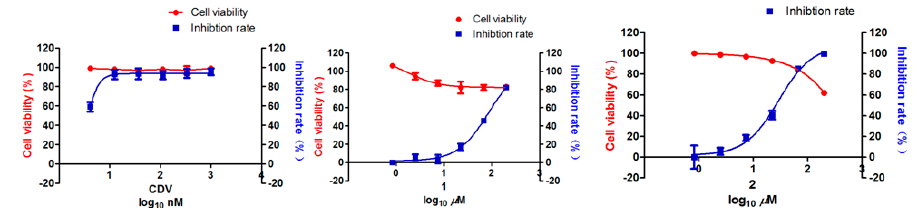
Figure 5. The effects of positive control cidofovir (CDV), 1 and 2 on human iSLK.219 cells viabilities and on lytic replication of KSHV infecting Vero cells were measured in vitro .